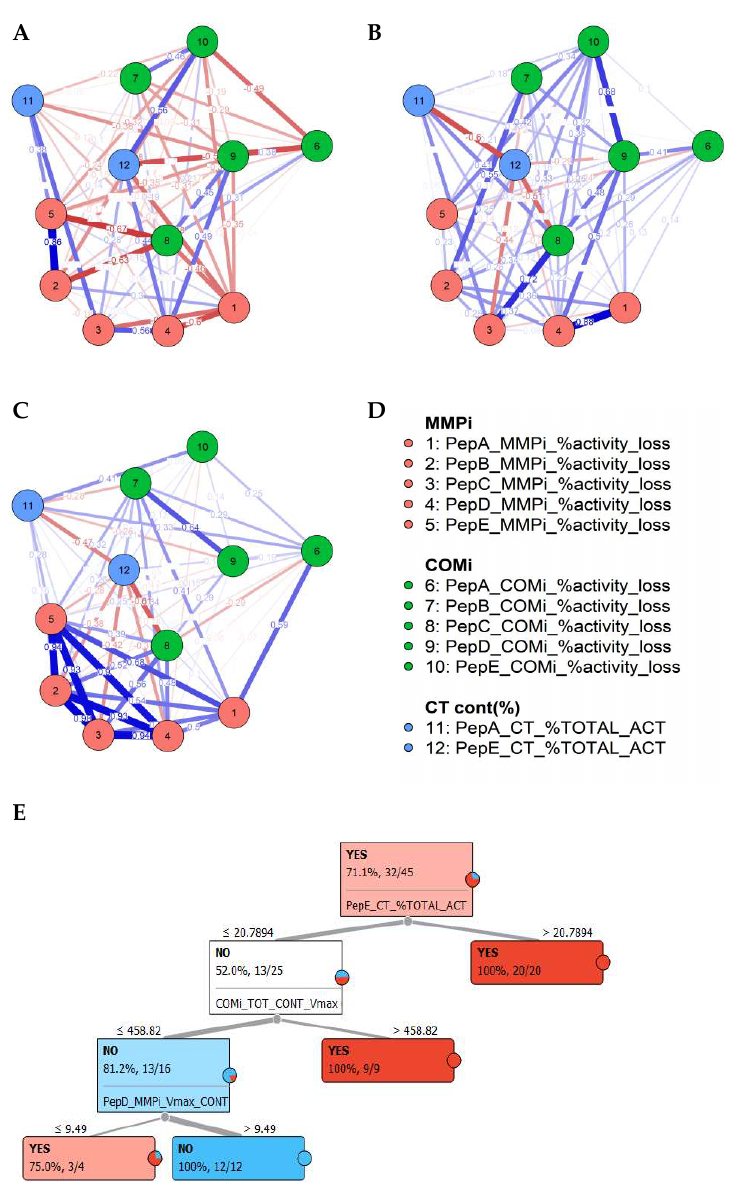
Figure 3. Delineation of caries status, based on the proteolytic fingerprints. A–D, Partial correlation demonstrating weighted correlations of inhibitors and activities between saliva samples from patients based on caries status as no caries saliva ( A ), caries saliva ( B ) and caries biopsy samples ( C ) and indicating conserved differences in salivary profiles, correlating with the biopsy material ( A – D ); Random Forest decision tree for salivary caries determination (YES/NO) for distribution-centred MLA classifier analysis ( E ).